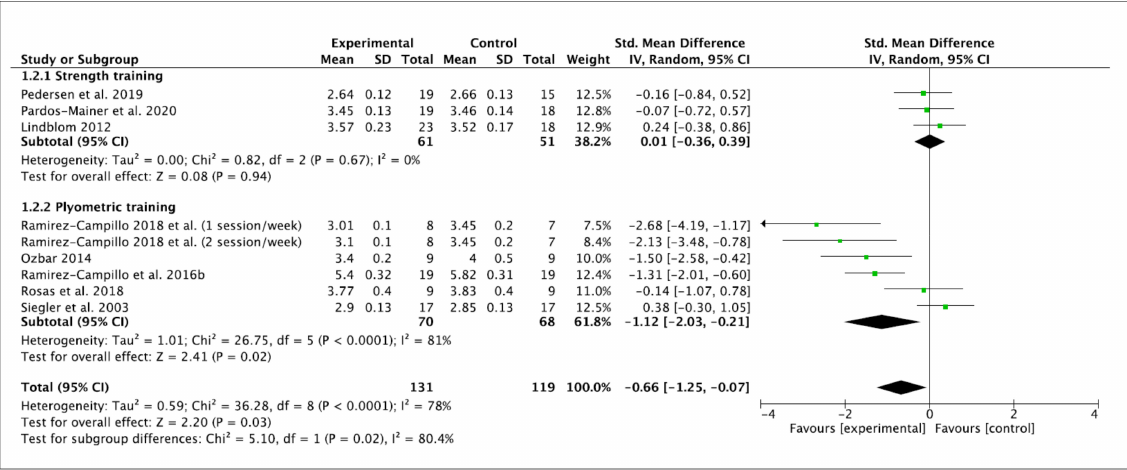
Figure 4. Forest plot of between-mode effect sizes with 95% confidence intervals (CIs) in time of linear sprint (s). IV: inverse variance method; SD: standard deviation; Std: standardized.